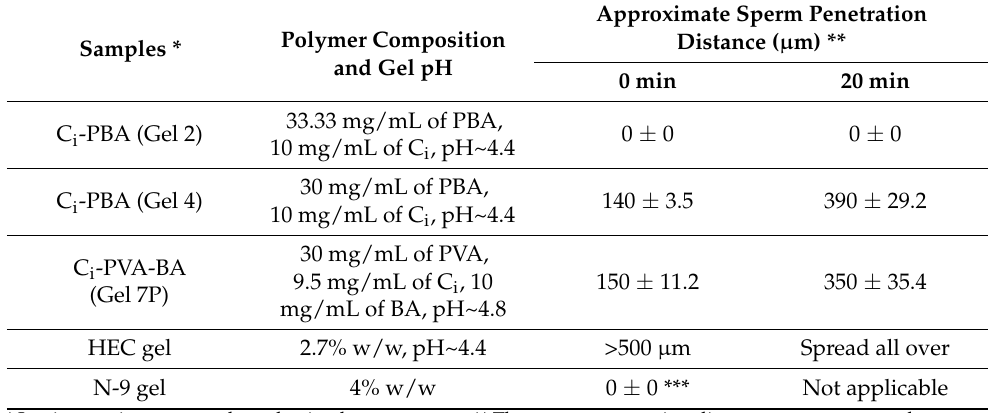
Table 4. In vitro sperm penetration testing results of C i -PBA and C i -PVA-BA gels and controls.